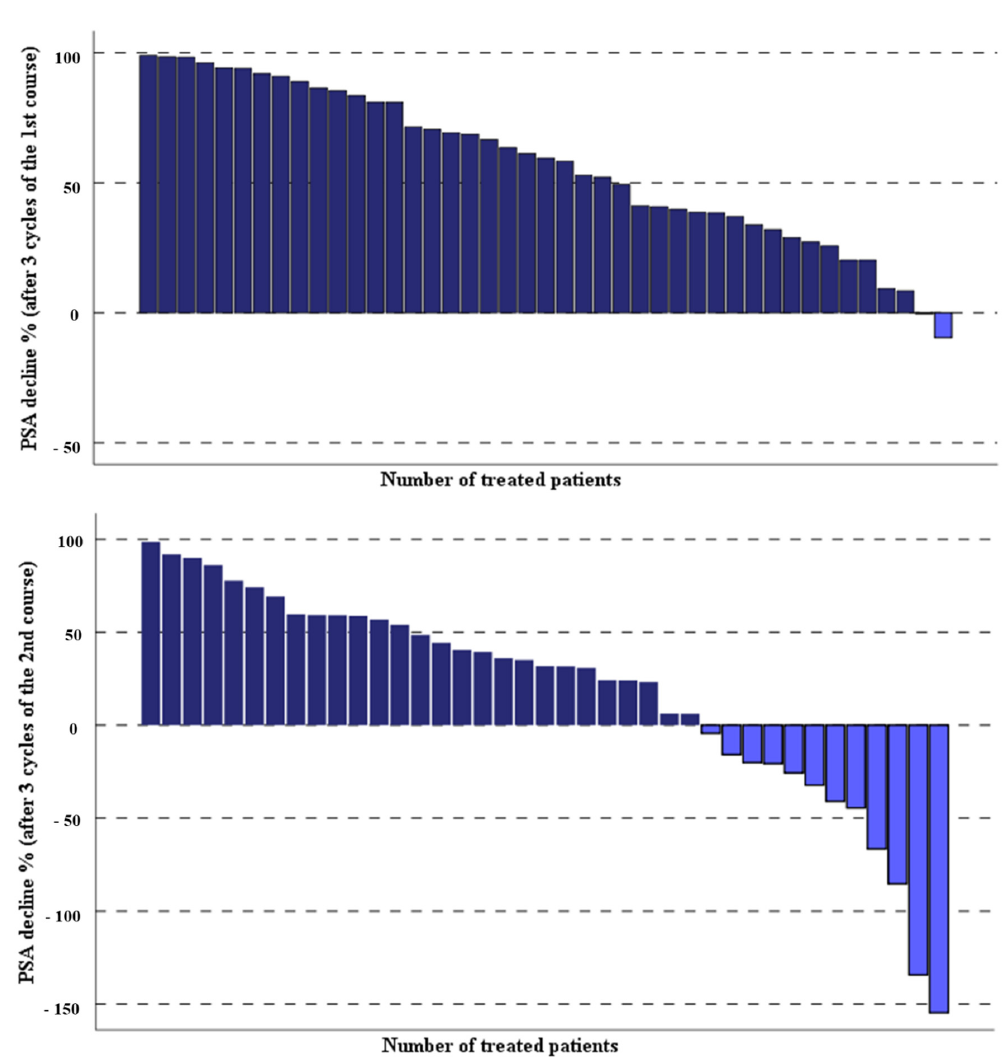
Figure 1. Percentage of PSA change in the studied patients after two courses of the highly standardized PSMA-RLT, each three cycles with 4-week